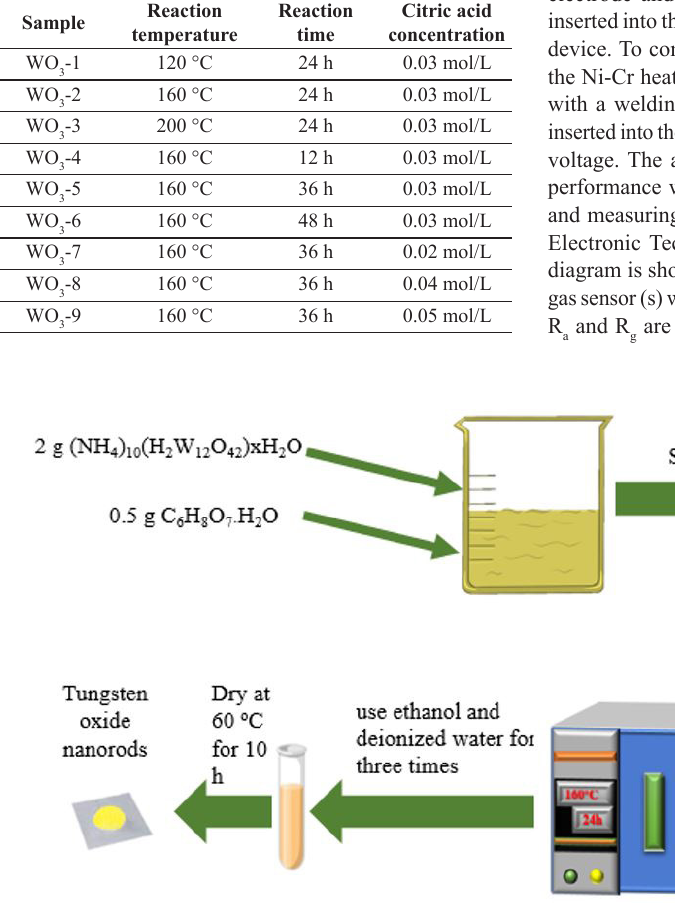
Figure 1. Schematic illustration of the synthesis process of WO